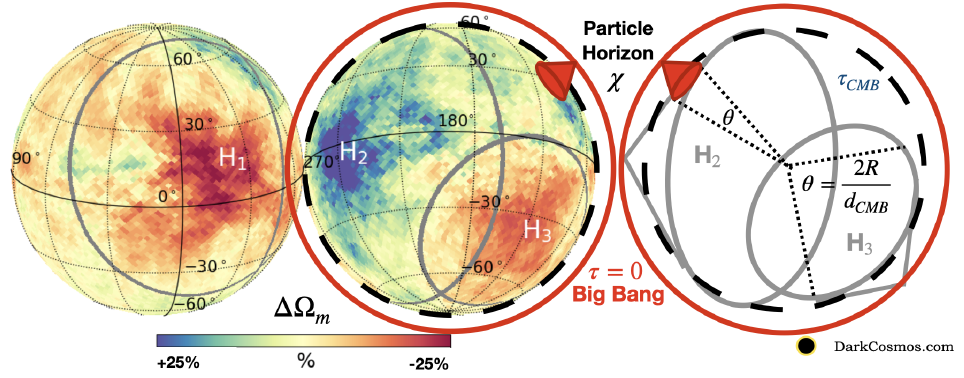
Figure 6. The CMB sky represented as the surface of a sphere (two view angles) whose radius is the distance traveled by the CMB light to reach us (at the center of the sphere). The red circle represents the corresponding spherical surface from the Big Bang light ( τ = 0), if we could see it. The CMB particle horizon χ ∼ r H (small red cones) is the distance travel by light between τ = 0 and τ CMB and subtends a very small angle in the observed CMB sky. Large grey circles on the CMB surface are therefore super-horizon boundaries (labeled H 1 , H 2 and H 3 ) in the relative variations of cosmological parameters (color scale) at different locations of the CMB sky [9]. Regions H i correspond to a cutoff in super horizon perturbations (of size θ (cid:39) 2 R / d CMB (cid:39) 60 deg.) out of the τ = 0 surface. They are inside our BHU, but not causally connected (yellow region in Figure 4).